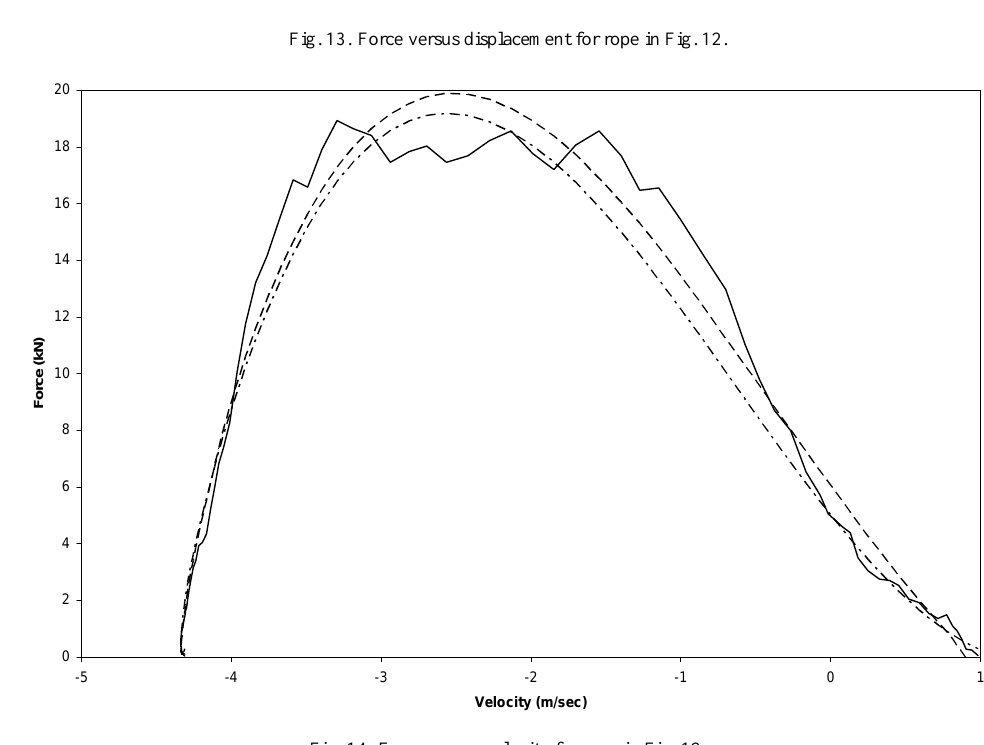
Fig. 14. Force versus velocity for rope in Fig.